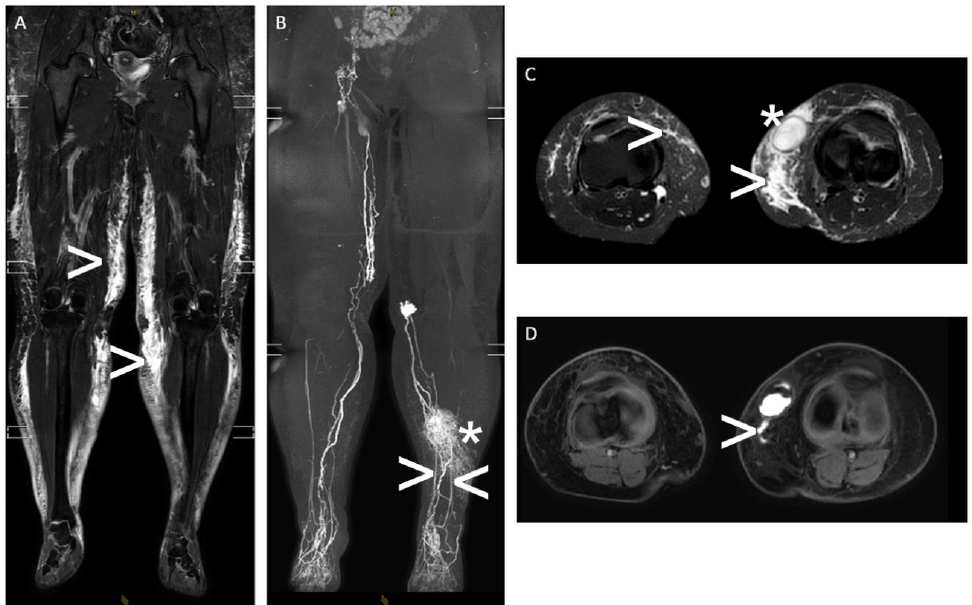
Figure 6. “Interstitial MR lymphangiography“— A 43-year-old woman with massive lymphedema of both legs and a refractory superficial lymphocele medial to the left knee with an intermittent cutaneous lymphatic fistula after multiple plastic surgeries of the legs. Note: ( A , C ) T2-weighted, fluid-sensitive MRI (( A ): coronal plane and ( C ): axial plane) showing subcutaneous lymphedema of both legs (white arrowhead) and the lymphocele of the left leg (white asterisk); ( B , D ) contrast material (gadolinium)-enhanced “interstitial MR lymphangiography” ( B ): coronal maximum-intensity projection and ( D ): axial plane showing impaired lymphatic run-off of both legs with dilated superficial lymph ducts, dermal reflux on the left (white asterisk), and active lymphatic fistula draining into the lymphocele on the left with two superficial lymphatic feeders (white arrowhead).